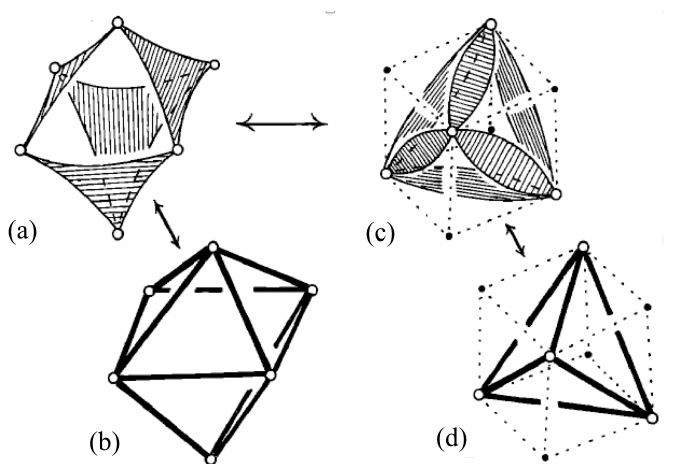
Figure 37. The opposite faces of a convex octahedron form an isostatic sheetwork ( a ), with the octahedral framework as a model ( b ). A polar is the sheetwork on opposite vertices of the cube ( c ), with the tetrahedral framework as a model ( d ). Figures are adapted from